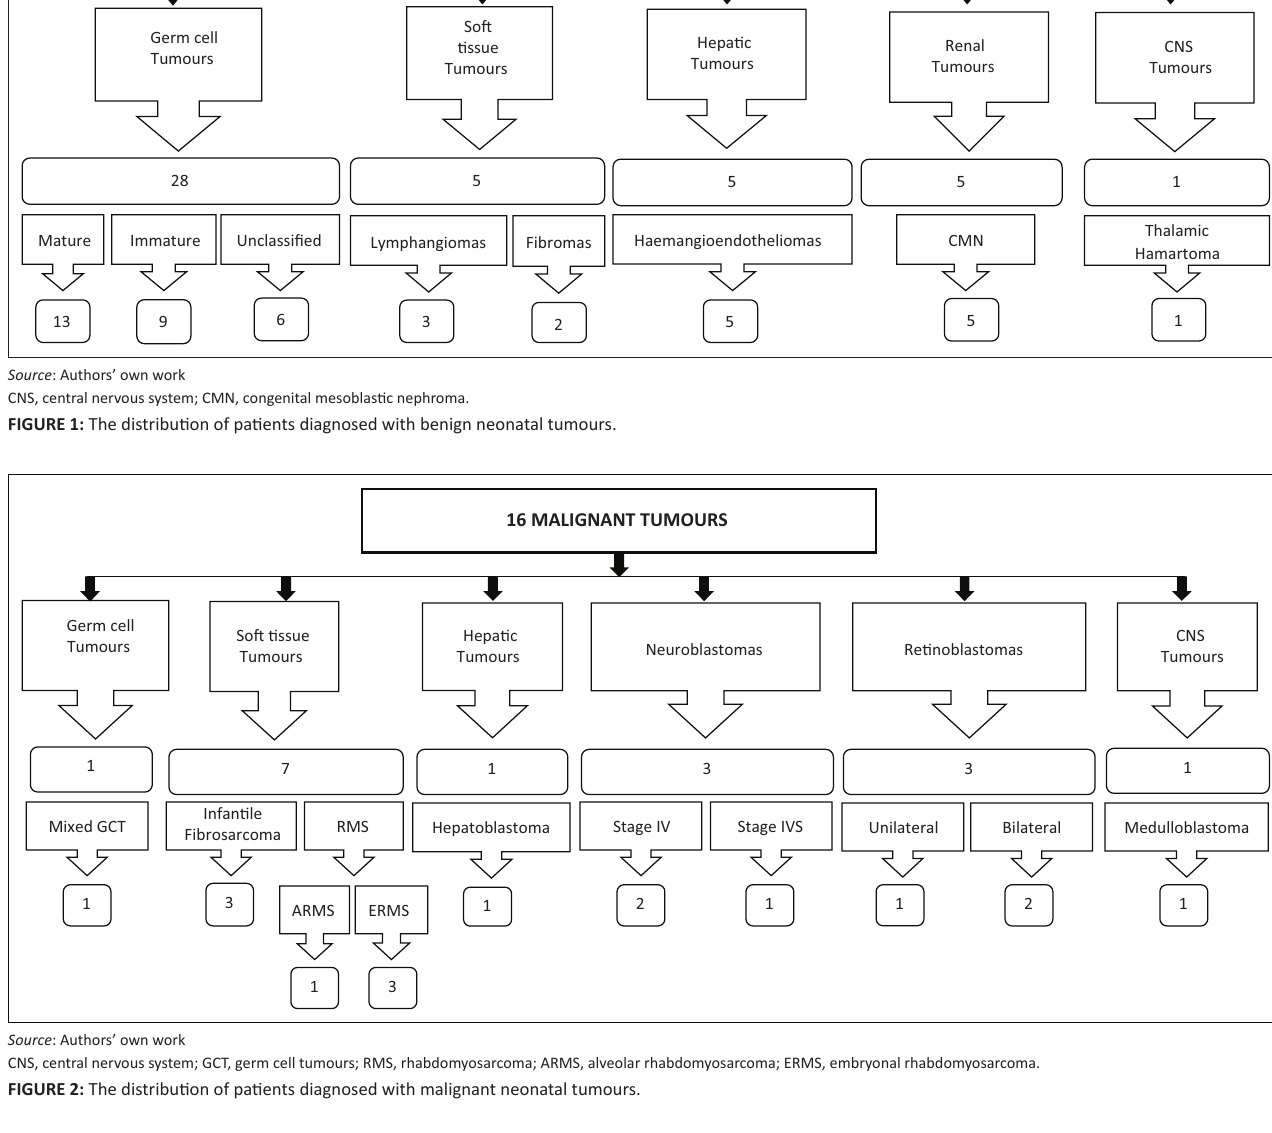
FIGURE 2: The distribution of patients diagnosed with malignant neonatal